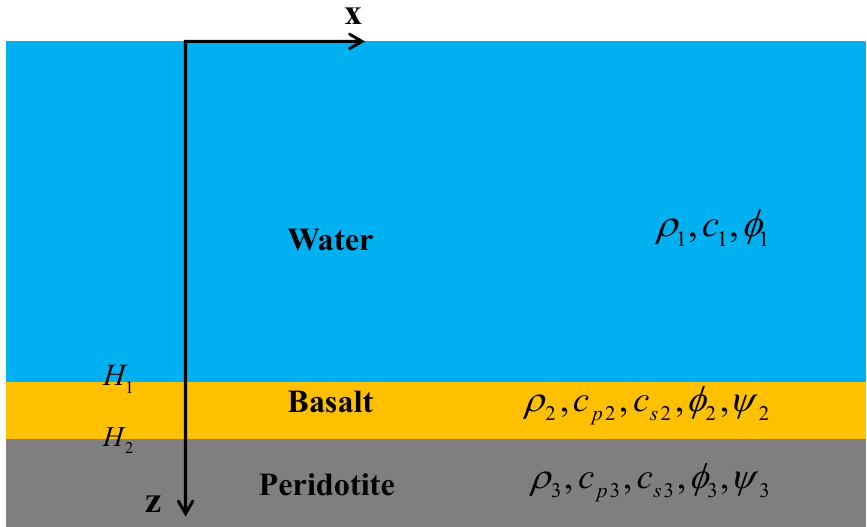
Figure 1. Schematic of the acoustic model for the marine environment. H 1 and H 2 are the interface depth for “water–basalt” and